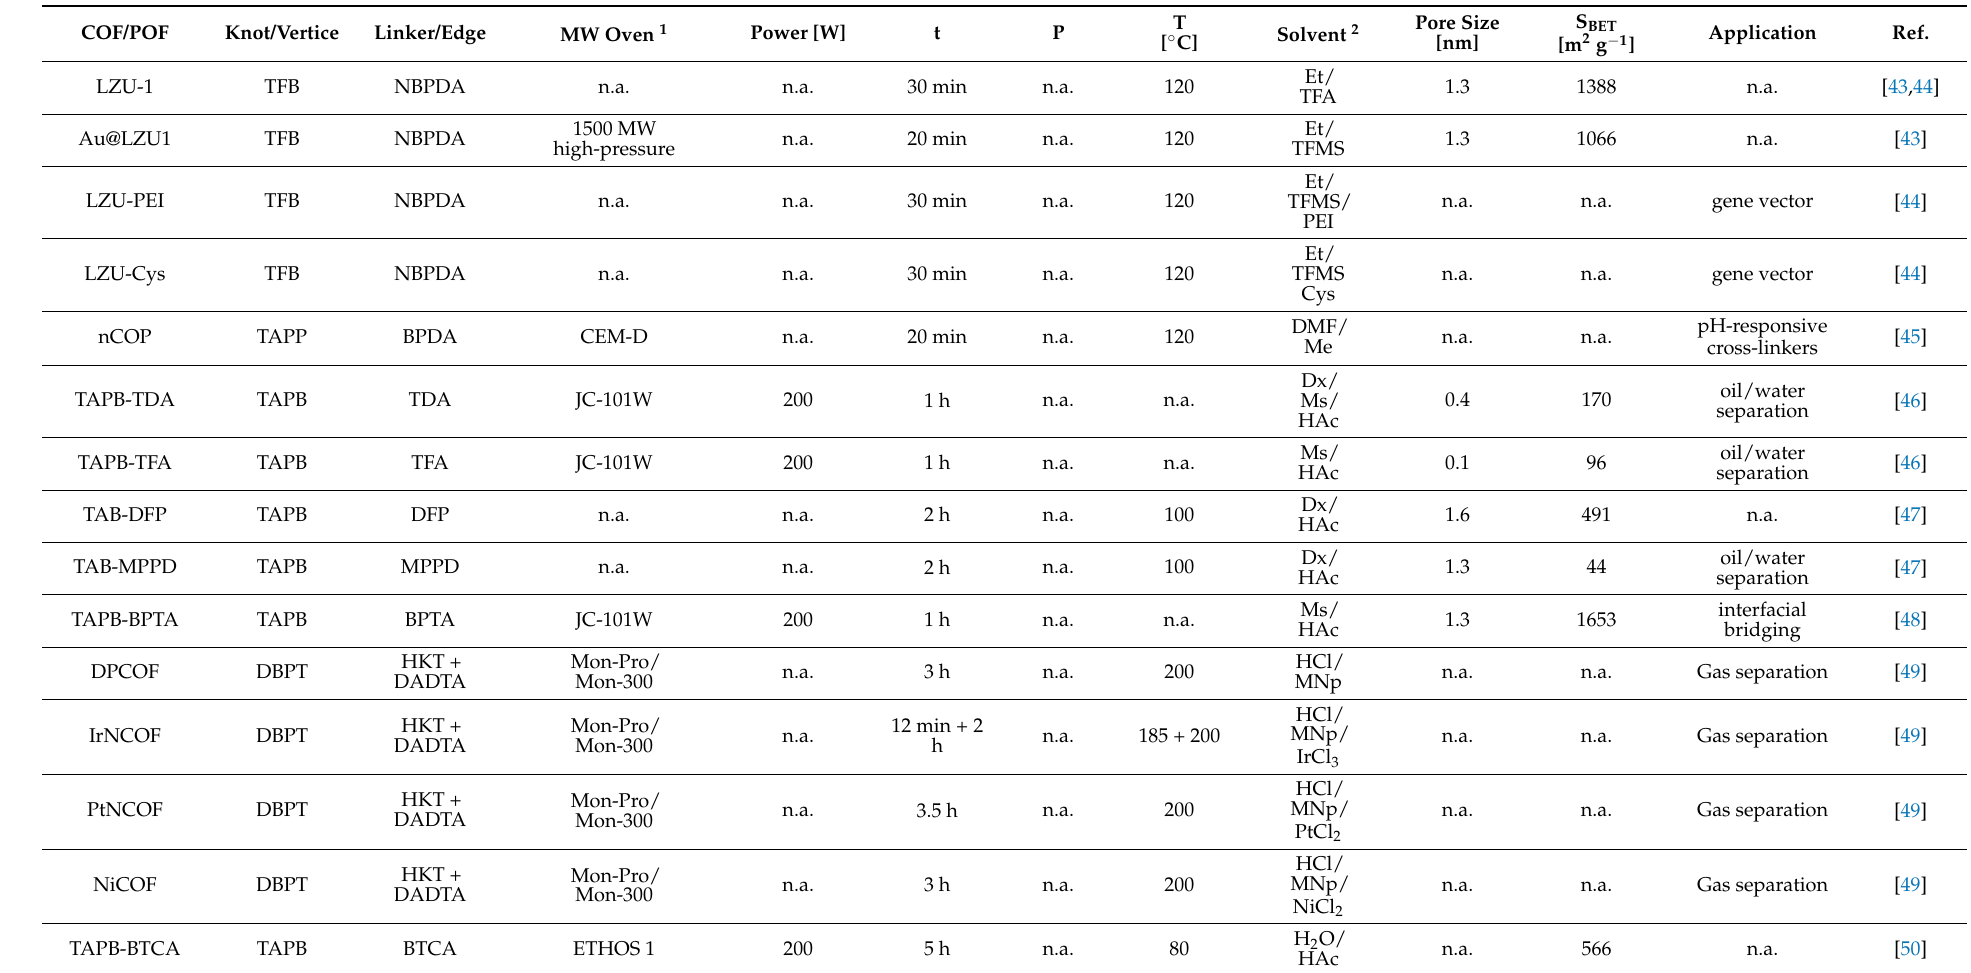
Table 1. COFs are summarized in the review with their main synthesis parameters and